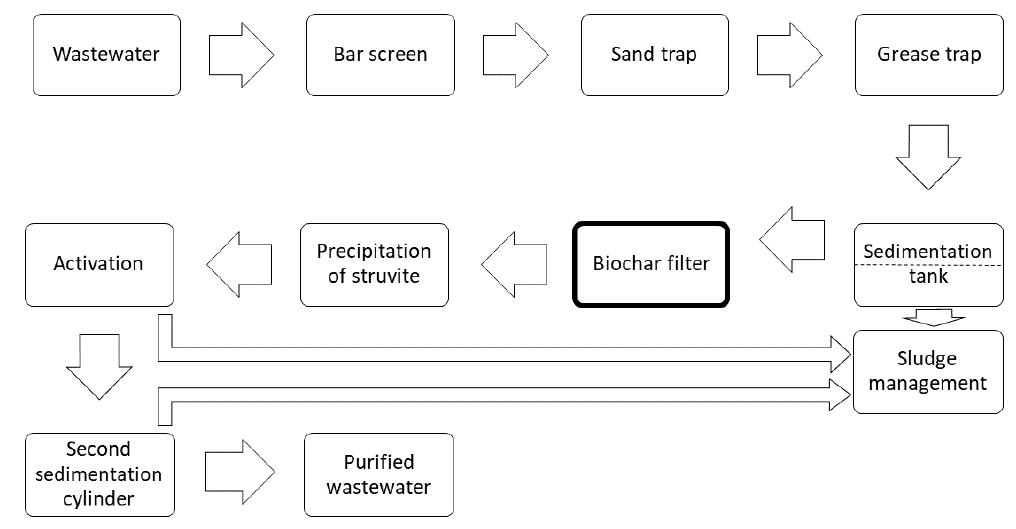
Figure 1. Wastewater management process.